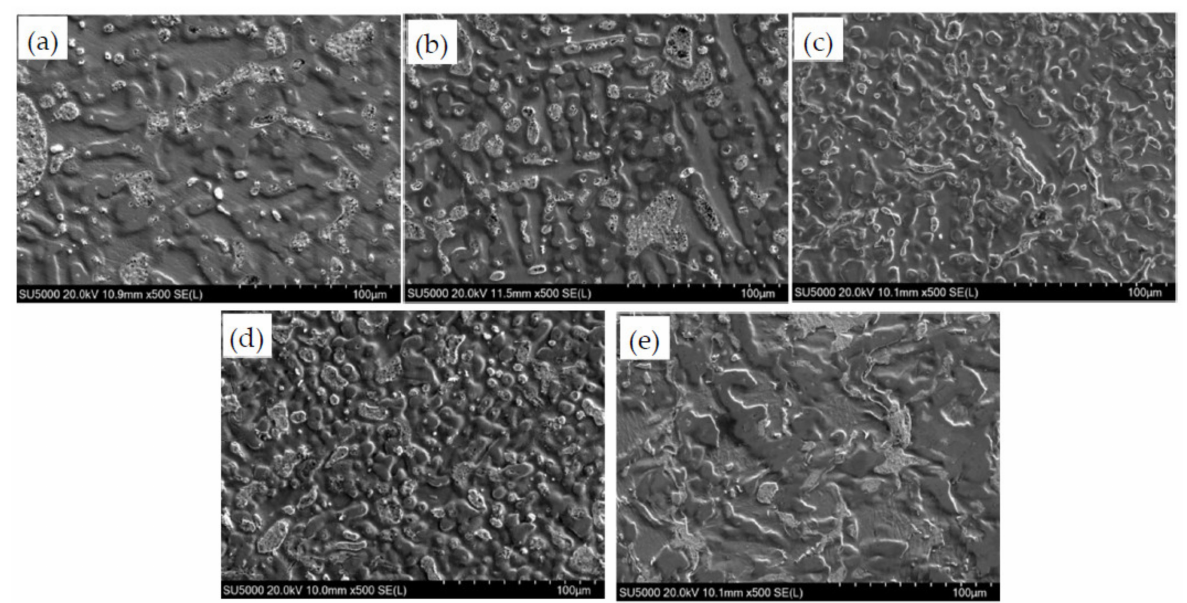
Figure 5. BSE microstructure of the ZCuPb20Sn5-0.1P-yB-zY alloy at 500 times. ( a ) B = 0 wt.%; ( b ) B = 0.01 wt.%; ( c ) B = 0.05 wt.%; ( d ) B = 0.1 wt.%; ( e ) B = 0.2 wt.%.